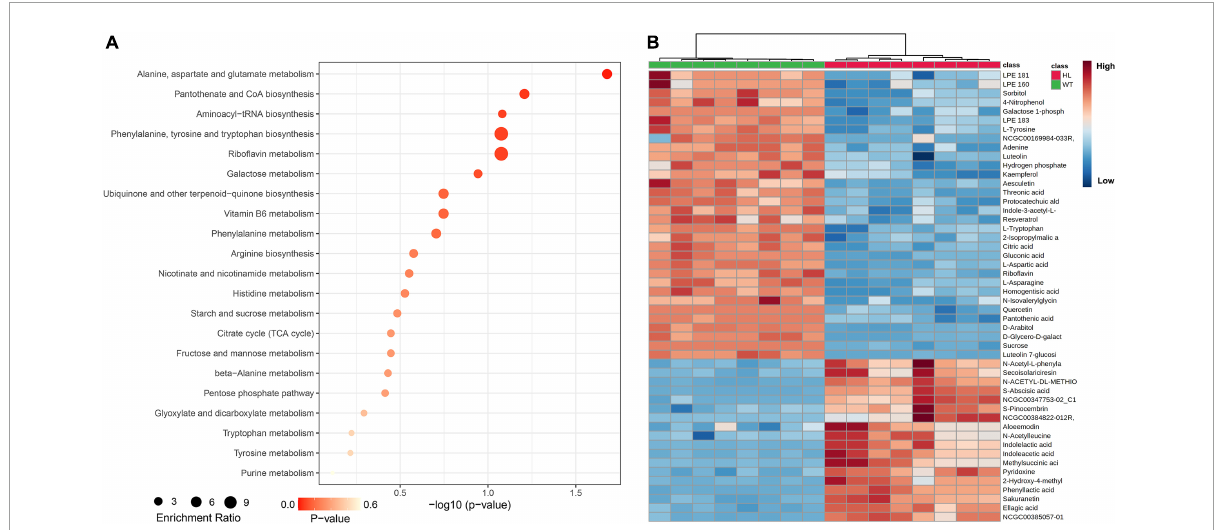
FIGURE2 Metabolic profiling analysis of the WT and HL. (A) KEGG classification of significantly different contents in dry mature seeds (harvested in the 20th week) between the WT and HL. Each point represents the degree of enrichment of the KEGG entry, and the size of each point indicates the number of different metabolites enriched in the KEGG pathway. (B) Heat map of metabolites with significantly different contents. Every square block indicates a metabolite, and significantly up-regulated and down-regulated metabolites are displayed in red and blue, respectively. HL, hybrid Euryale lines; WT, wild type (North Gordon